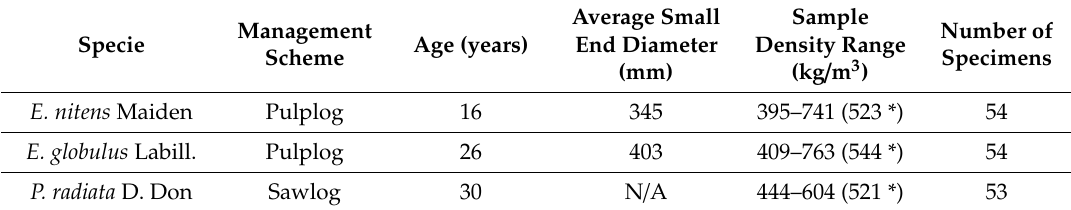
Table 1. Species sample data.